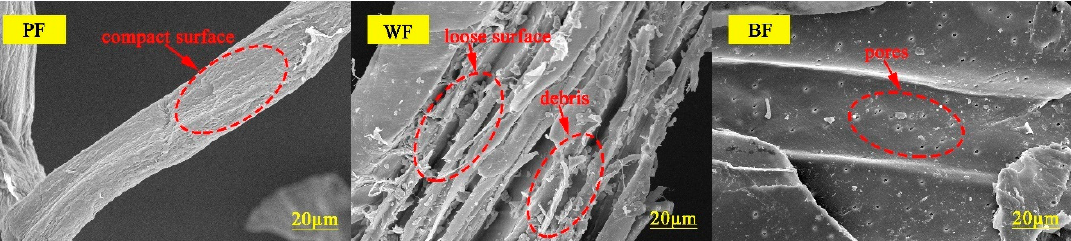
Figure 4. SEM images of the micro-topographies for PF, WF, and BF.